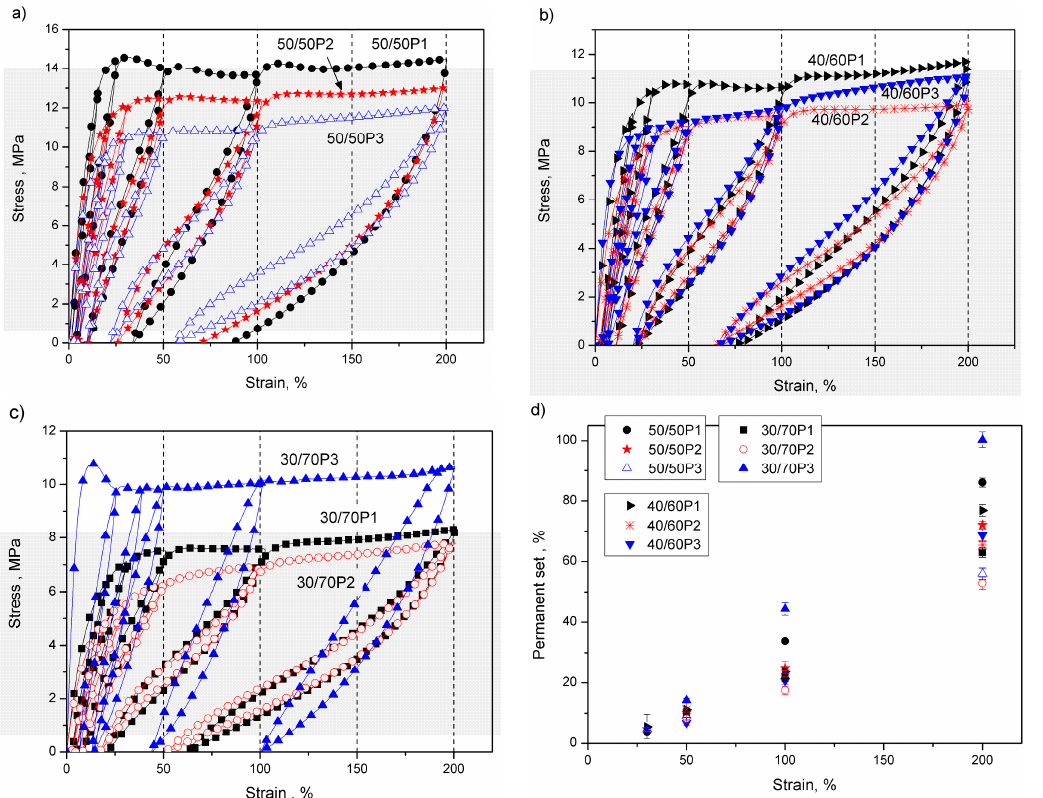
Figure 7. Stress–strain curves from cyclic tensile tests obtained for: ( a ) PTT- b -PEOT 50/5; ( b ) PTT- b -PEOT 40/60 and ( c ) PTT-b-PEOT 30/70 with PEG molecular weights of 1000, 2000 and 3000 g/mol and ( d ) permanent set of specimens in tension direction resultant from maximum attained strain in the cyclic deformation for PTT- b -PEOT copolymers.